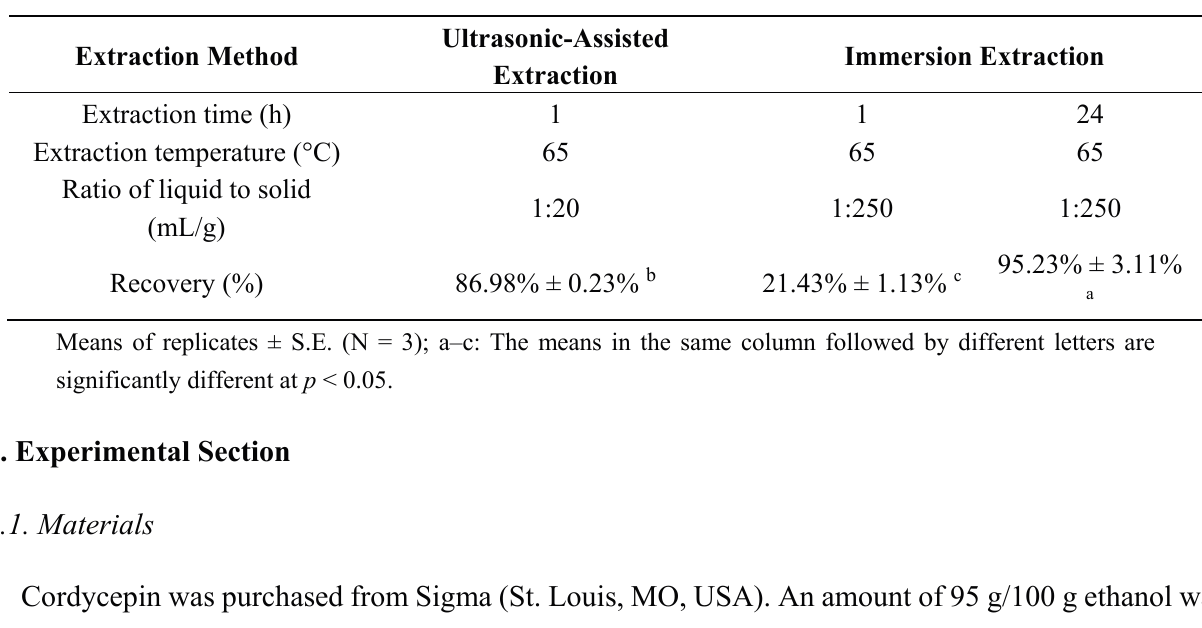
Table 4. Comparison of UAE and conventional immersion